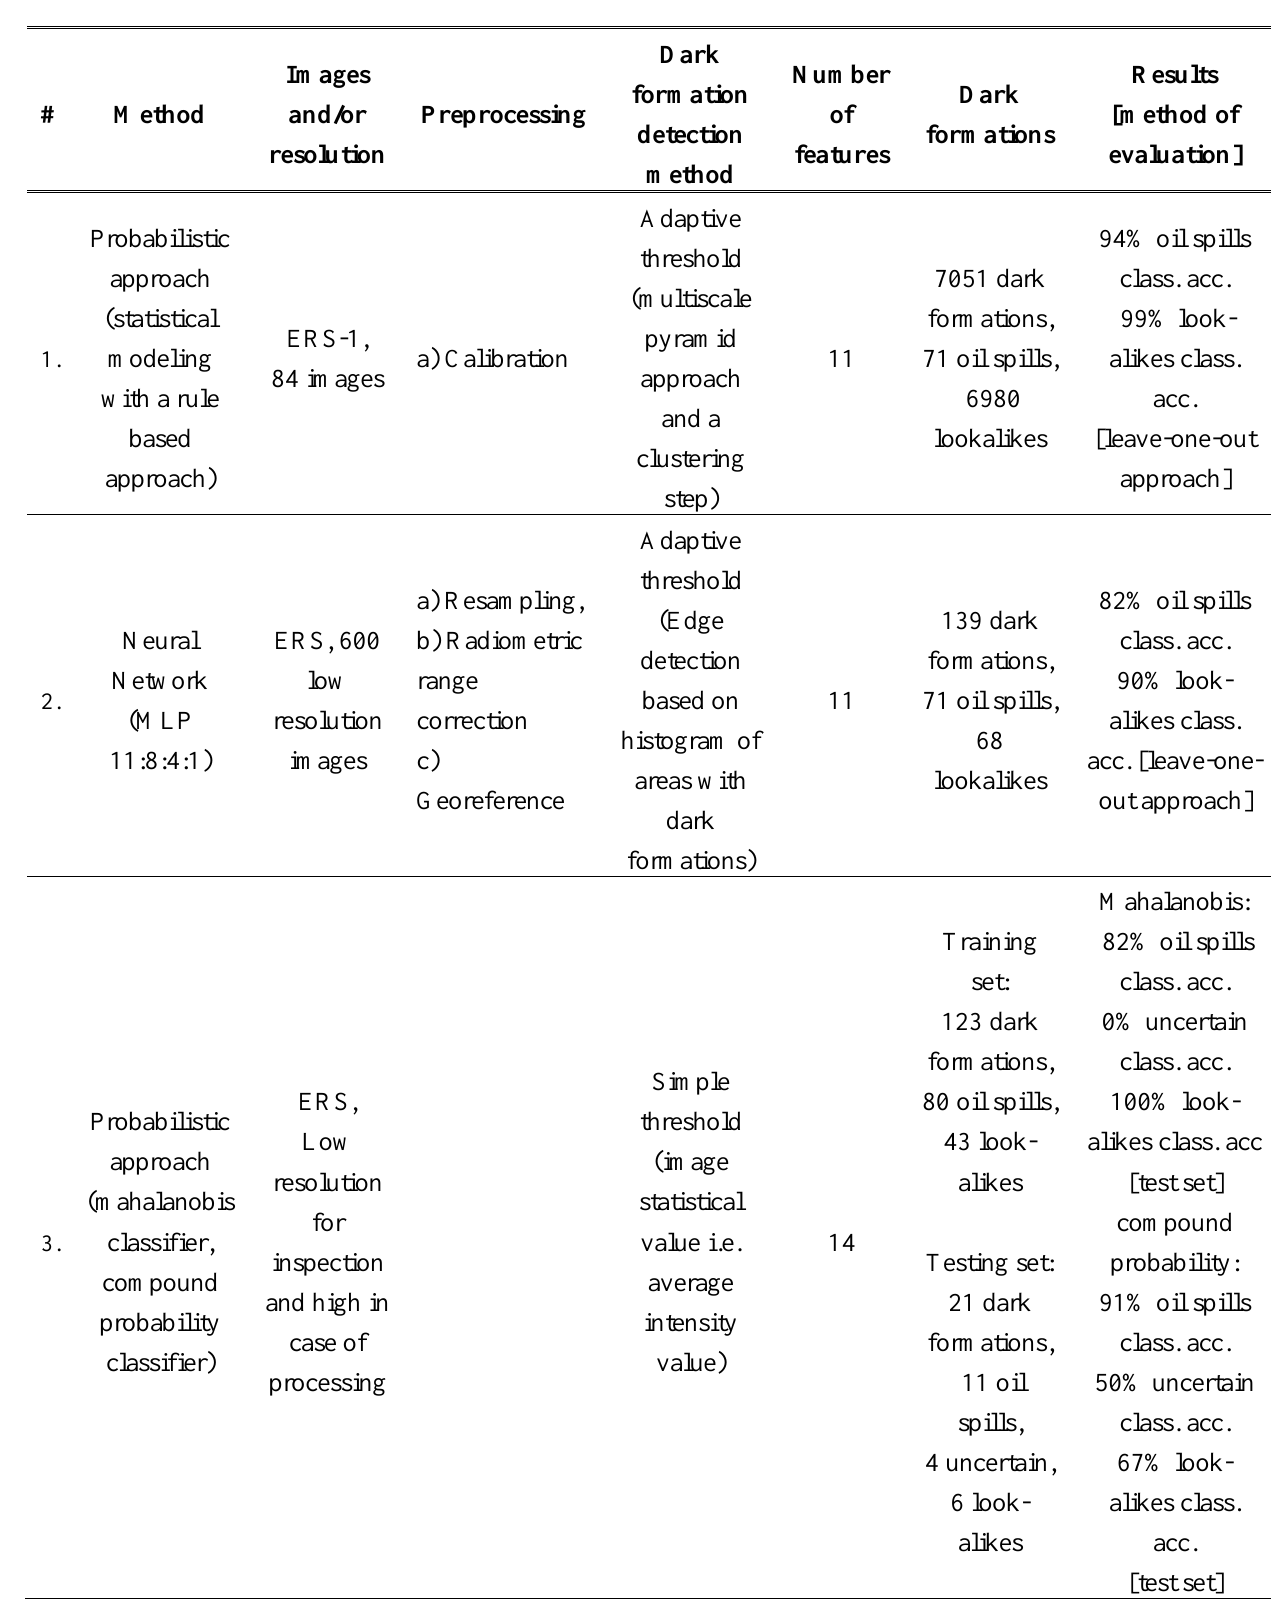
Table 4. Several oil spill detection approaches and their